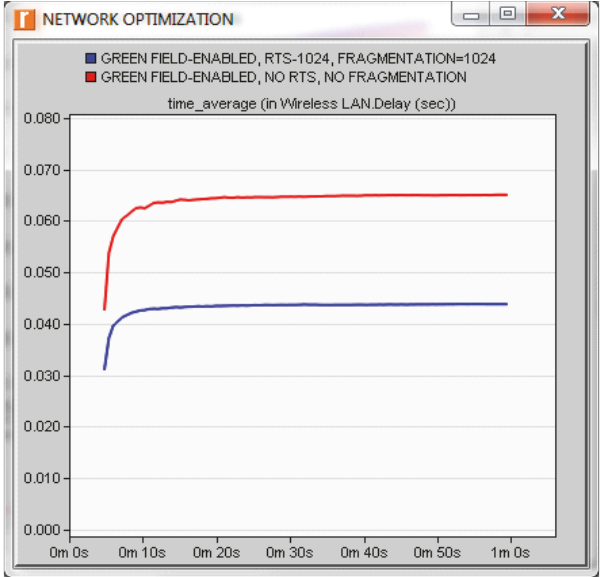
Figure 30: WLAN throughput optimization with RTS, fragmenta- tion, and Greenfield operation parameters.